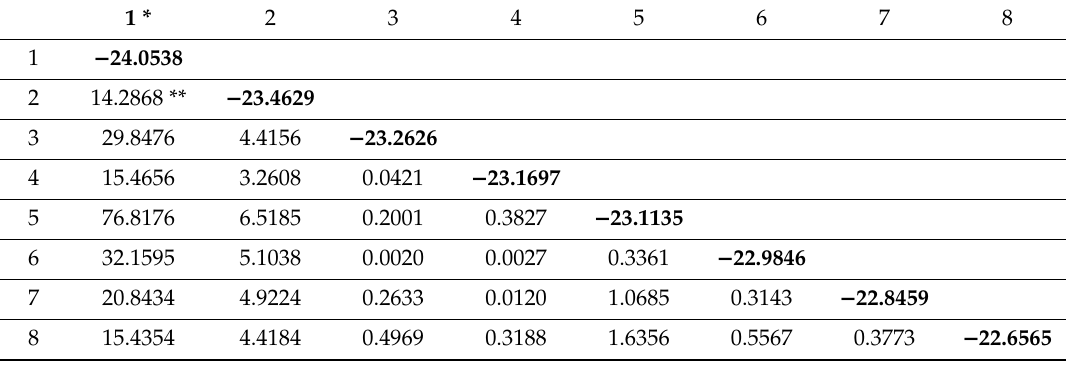
Table 1. Medians (highlighted in bold) and values of the Puri–Sen–Tamura statistics for function F for the Lapland Granulite Belt and granulites of Eurasia.